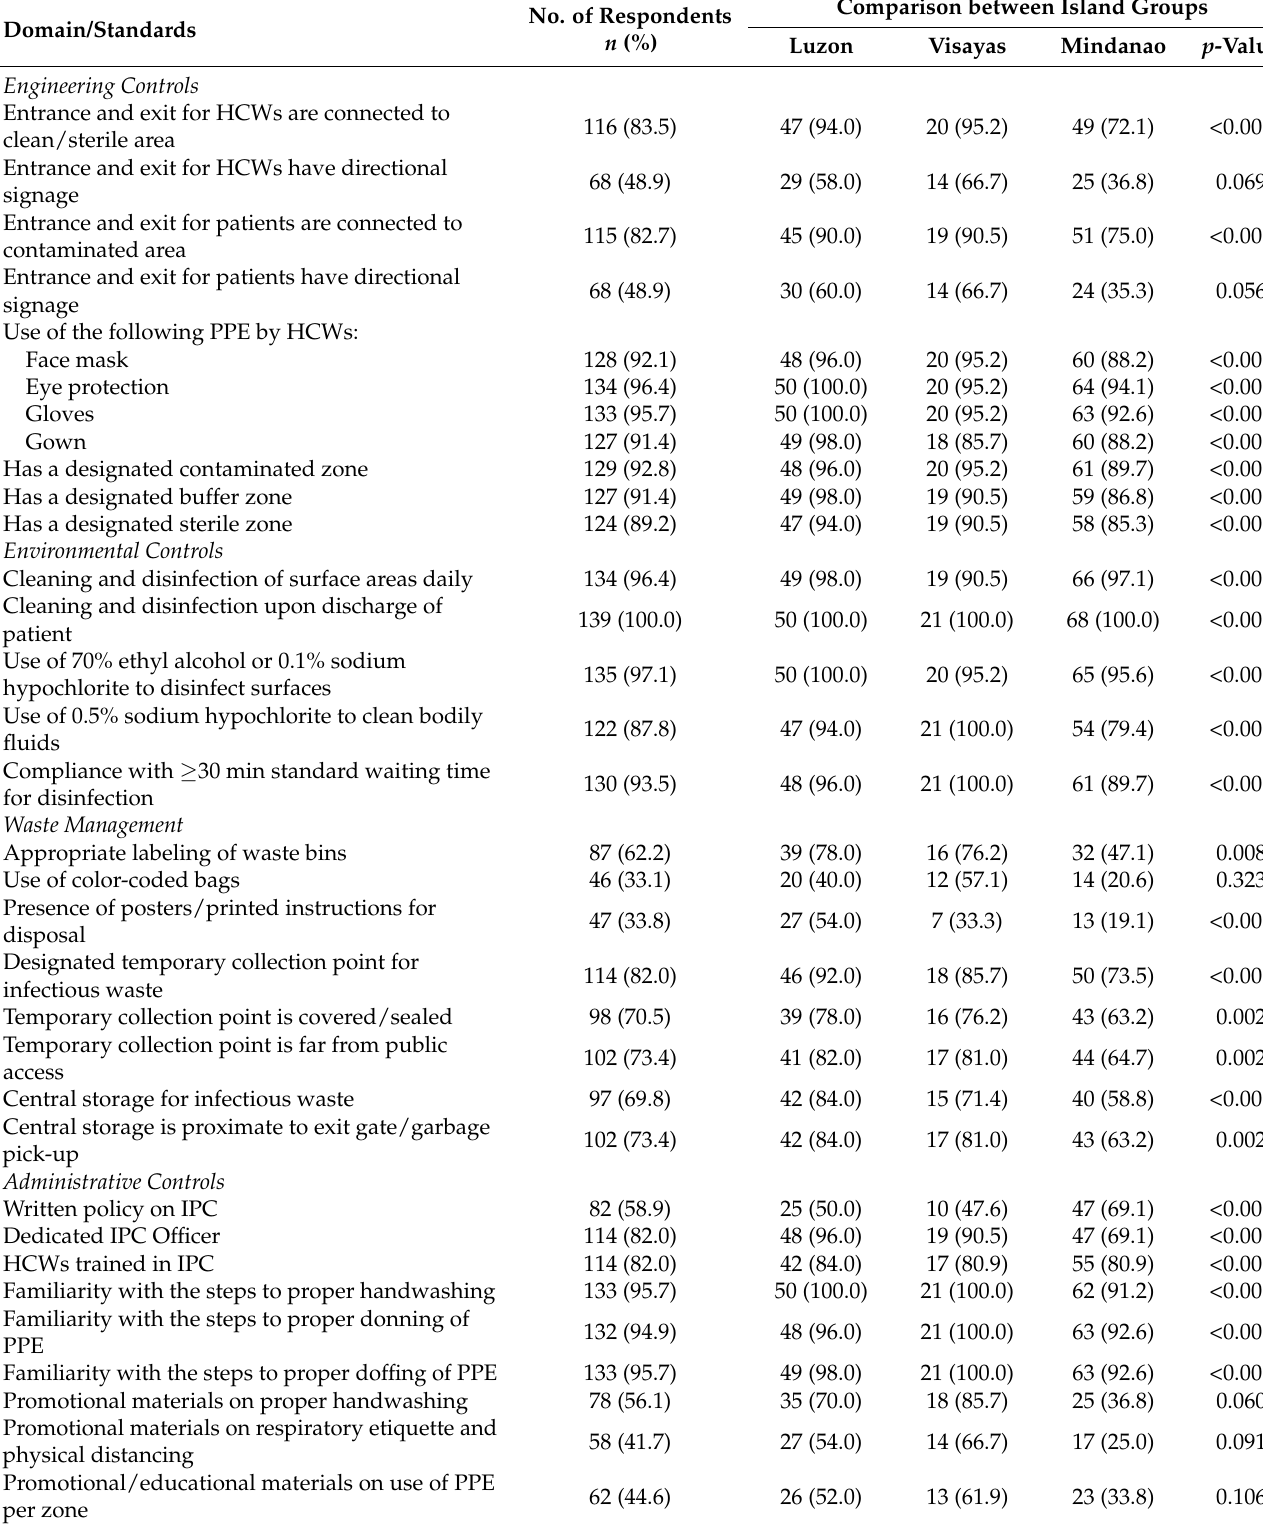
Table 3. Geographical comparison of TTMFs’ compliance to IPC standards, survey results from